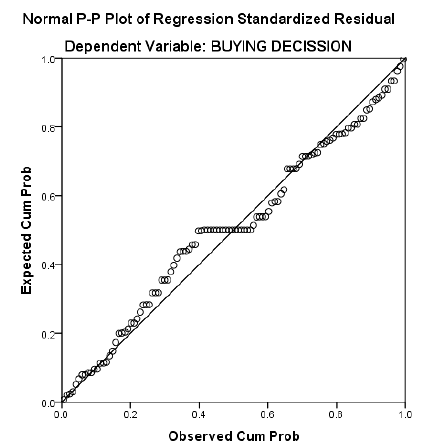
Figure 1. Model normality